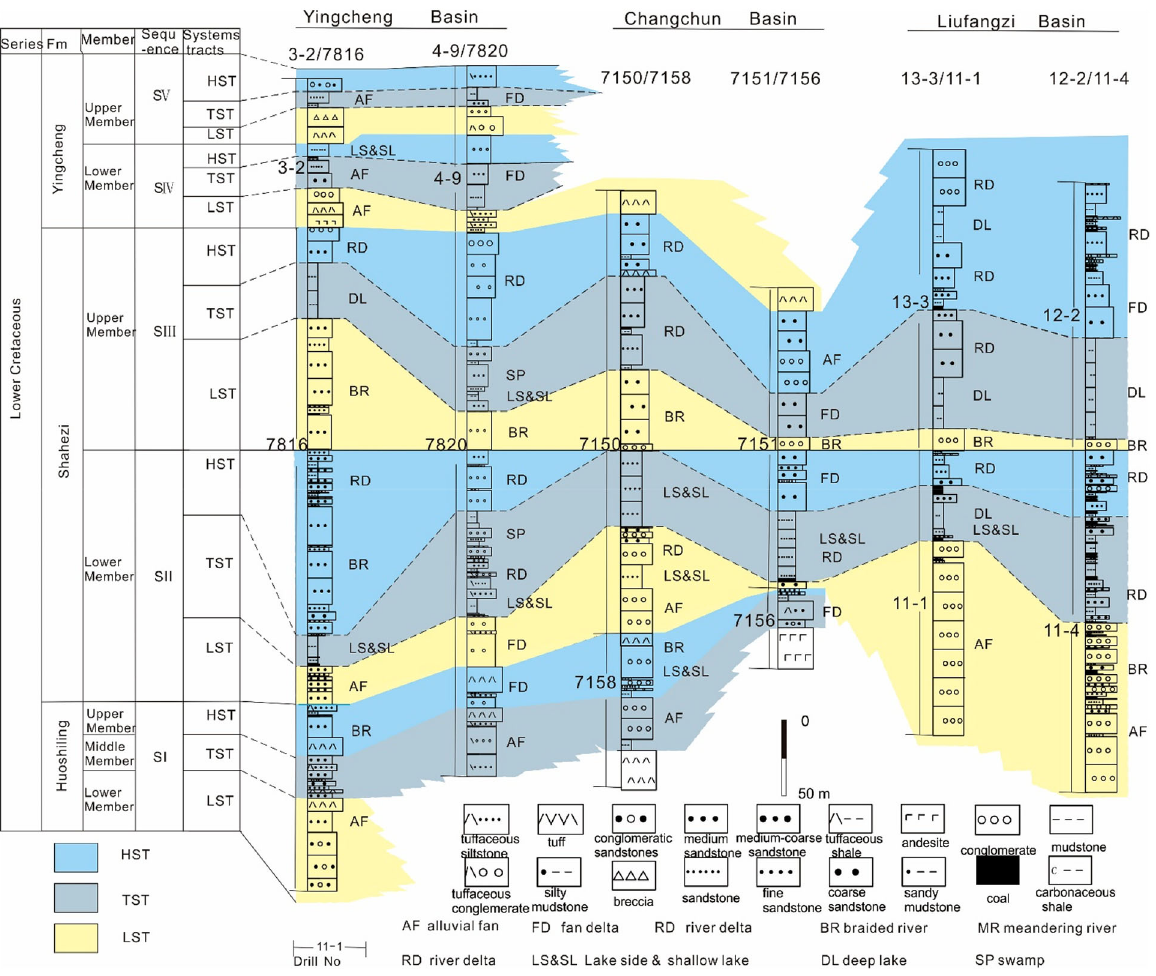
Fig. 3 Integrated columnar section showing sedimentary facies and sequence stratigraphy of the Early Cretaceous coal-bearing series in the southeastern margin of Songliao